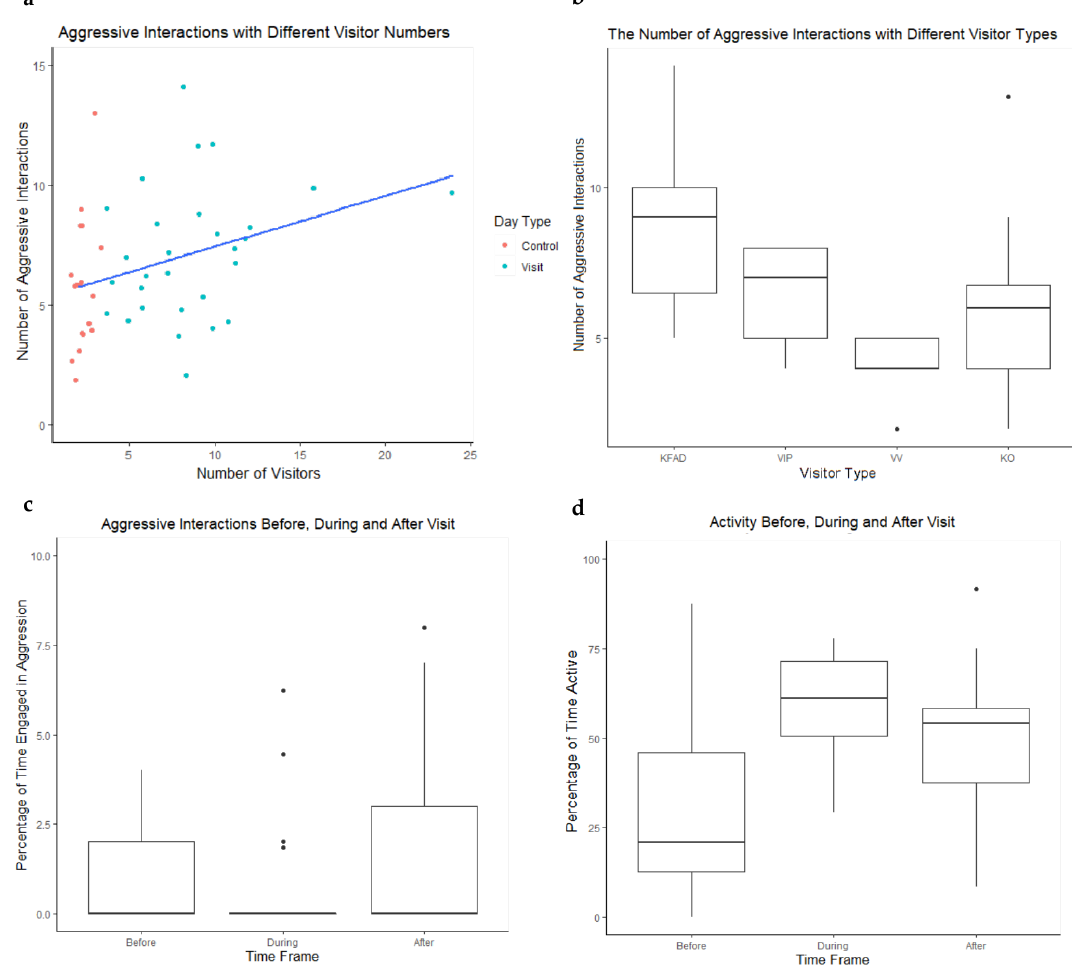
Figure 4. (a) The relationship between the number of visitors per day and the number of aggressive interactions that occurred between Galápagos tortoises on control and visitor days. Red dots indicate control days and blue dots indicate visitor days. (b) A box whisker plot showing the number of aggressive interactions per day with different visitor types, KFAD = Keeper for a Day, VIP = VIP Encounter, VV = Vet Visit, KO = Keeper Only. (c) A box whisker plot showing the percentage of time spent engaged in aggressive interactions before, during and after visit times. (d) A box whisker plot showing the percentage of time spent active before, during and after visit times. The bold line of the boxplot indicates the mean, the box indicates the upper and lower interquartile ranges, the whiskers indicate the highest and lowest observation and the points represent outliers.